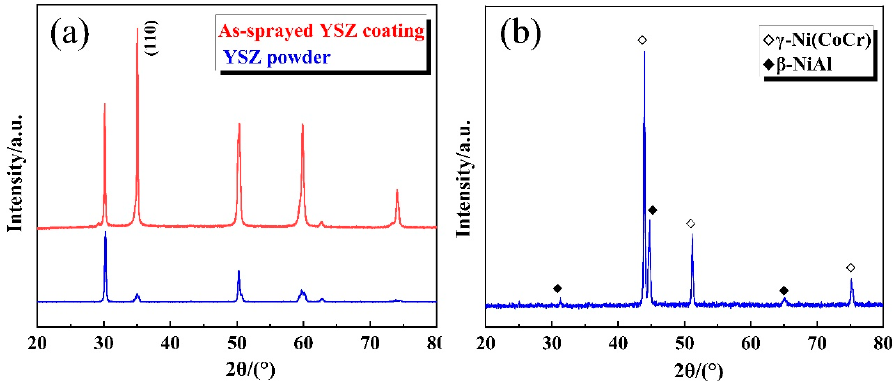
Figure 3. ( a ) XRD patterns of YSZ powder and the as-sprayed YSZ coatings; ( b ) XRD patterns of BC powder.